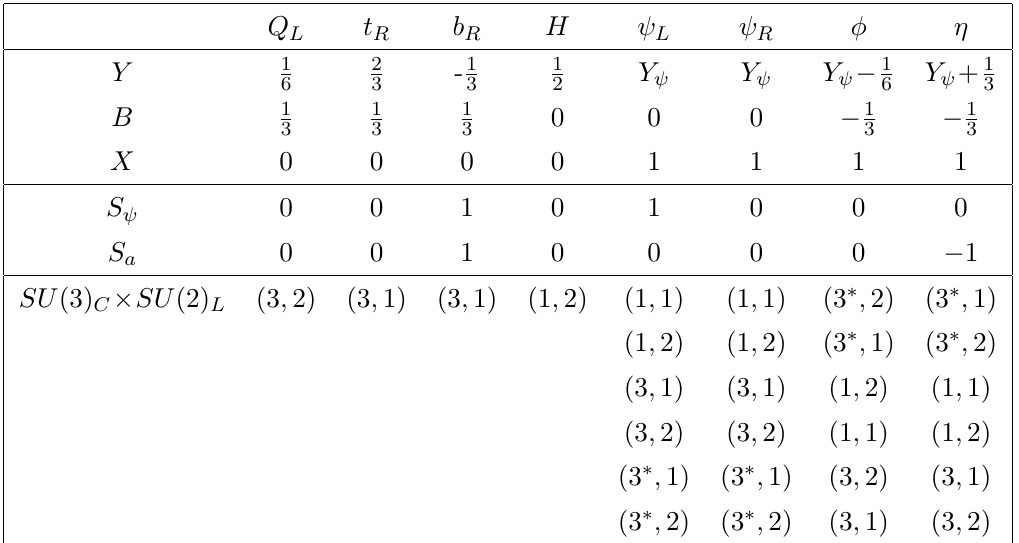
Table 3. Quantum numbers of fields for Class 1 b -quark models. The last six lines list the models containing only singlets and fundamentals under the SM gauge